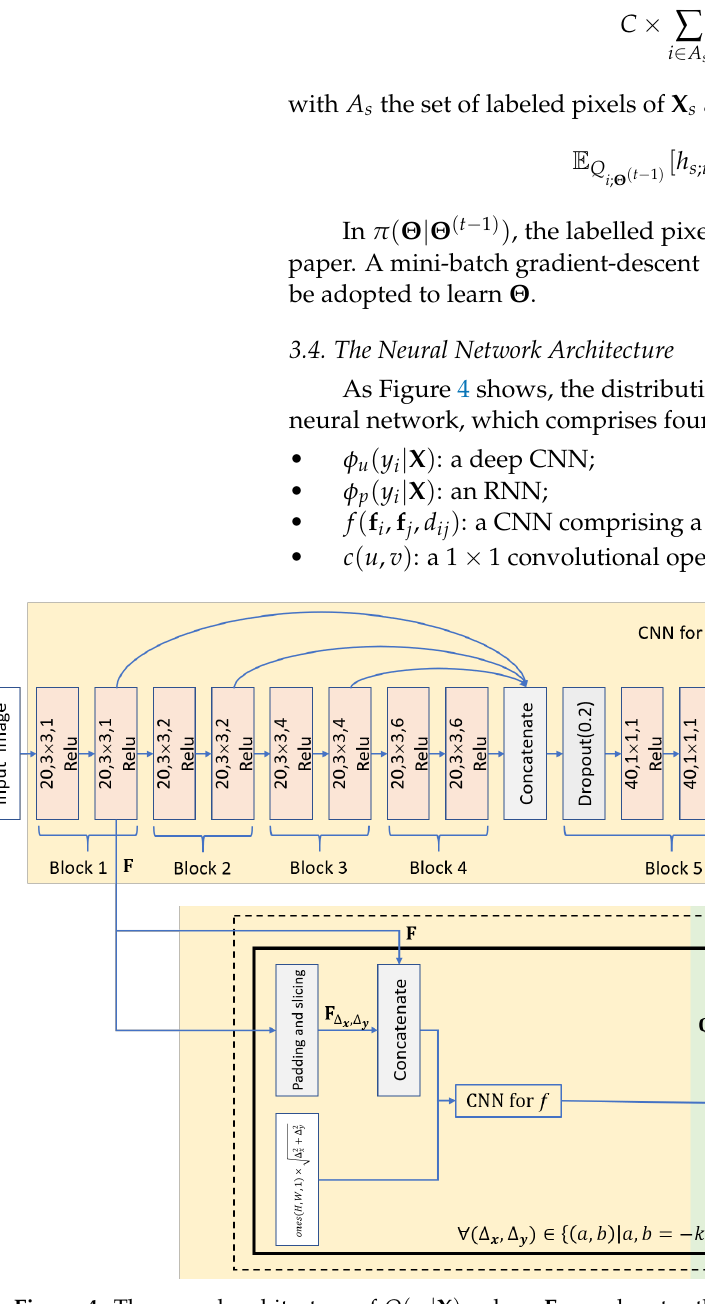
denotes the feature map, which is of the same size of F and ∆ x , y